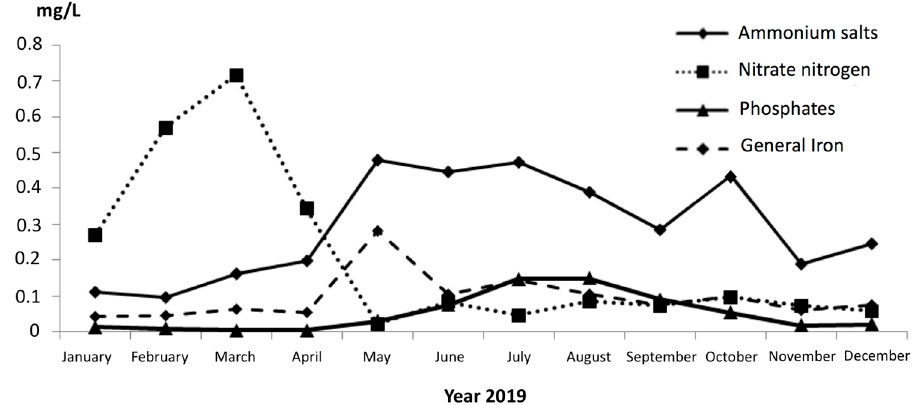
Figure 5. Seasonal changes in biogenic and inorganic ions in the water of the Ishim River within the Akmola Region in 2019 (mg/L)